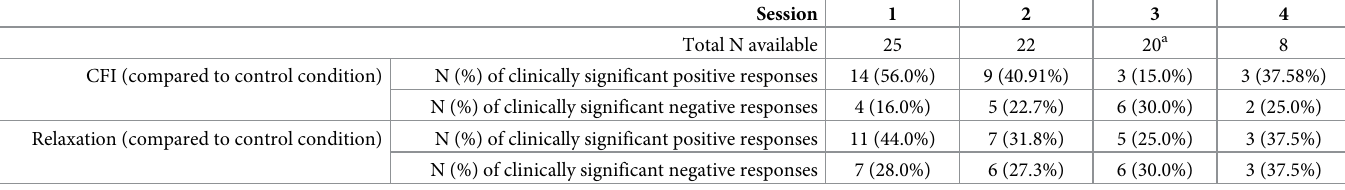
Table 2. Number and % of participants demonstrating a clinically-significant difference on RMSSD HRV (comparing compassion or relaxation task to